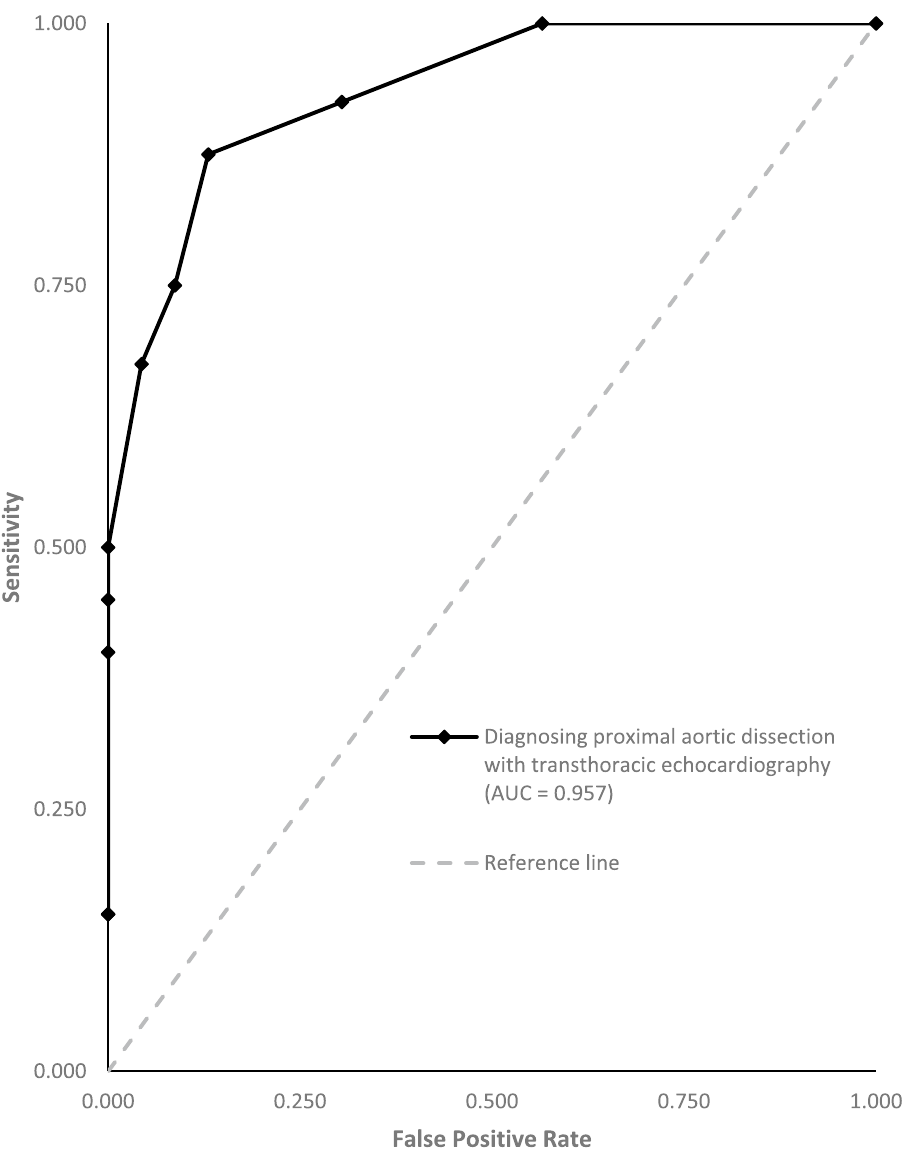
Figure 5. Overall SROC curve plotting sensitivity (true positive rate) against 1-specificity (false positive